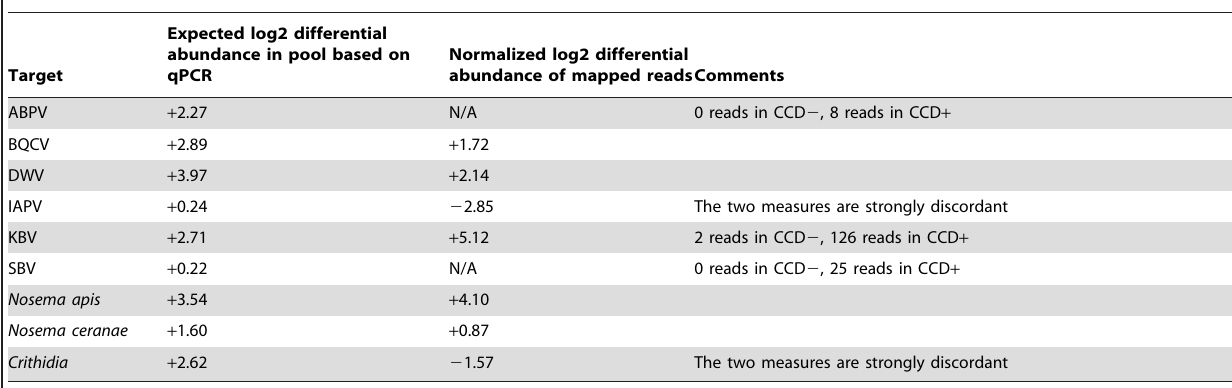
Table 8. Comparison of RNA target abundances in Illumina sequence reads compared with qPCR results.